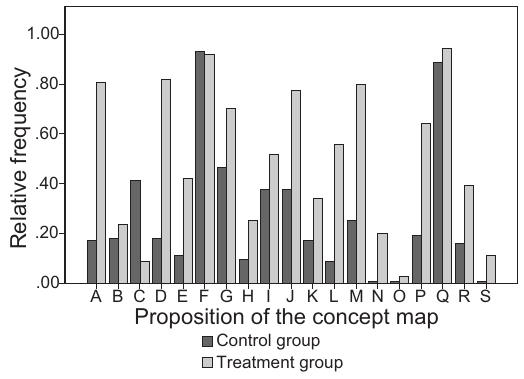
FIG. 5. Relative frequency of correctly phrased propositions for CG and TG. Propositions’ labels correspond to the expert’s map (cid:1) Table I and VIII (cid:2)